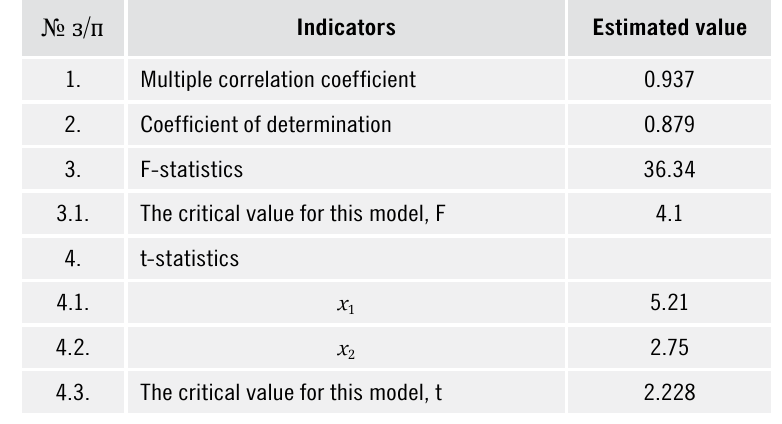
Table 4. Results of checking the adequacy of the economic-mathematical model on the main statistical